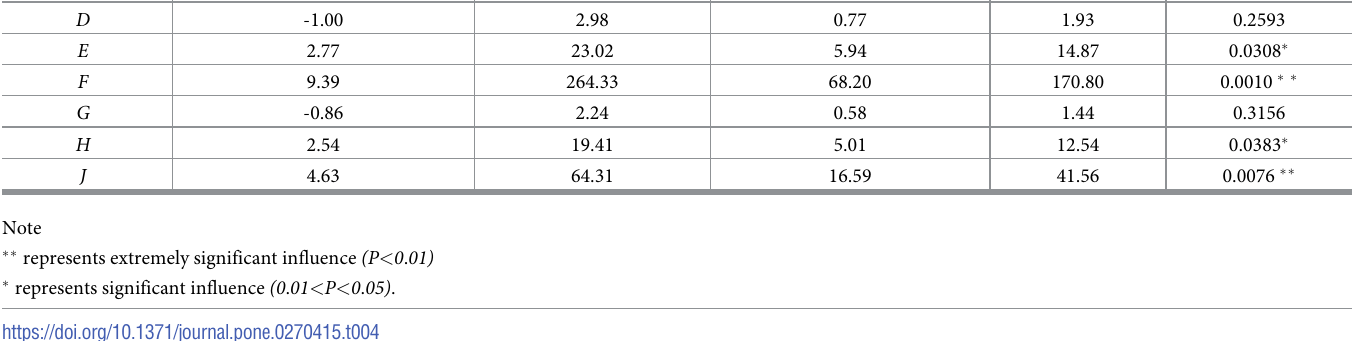
Table 4. Analysis of significance of parameters in Plackett-Burman test. Element Standardization effects